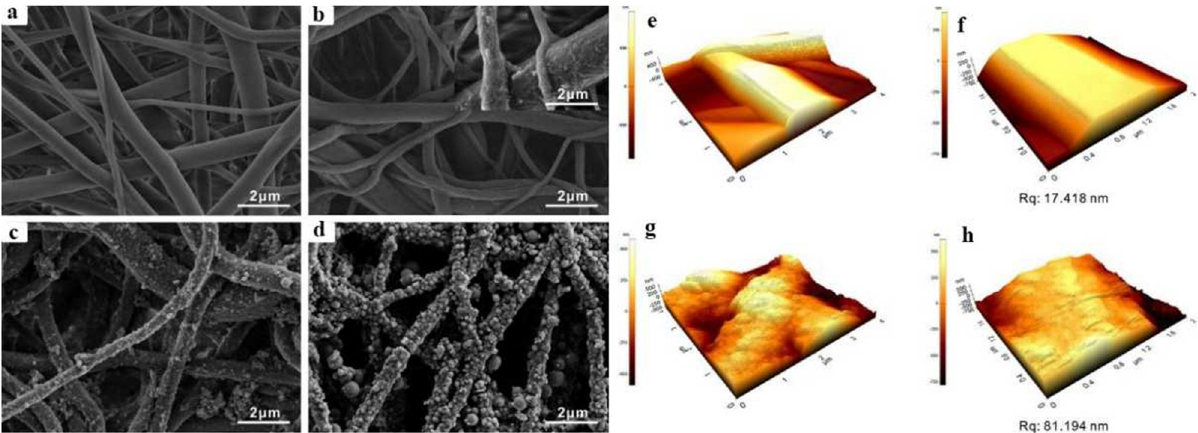
Figure 7: FE - SEM images of PU fi lm under di ff erent treatments: ( a ) untreated, ( b ) grafted with - NCO group, ( c ) treated with APTES, ( d ) clustered with SiO 2 [ 67 ] ; Copyright: 2019 with permission from Elsevier; AFM images of ( e ) raw polyurethane ( PU ) membrane, ( f ) raw PU membrane single fi ber, ( g ) SiO 2 /PU membrane, and ( h ) SiO 2 /PU membrane single fi ber [ 67 ] ; Copyright: 2019 with permission from Elsevier Science BV.